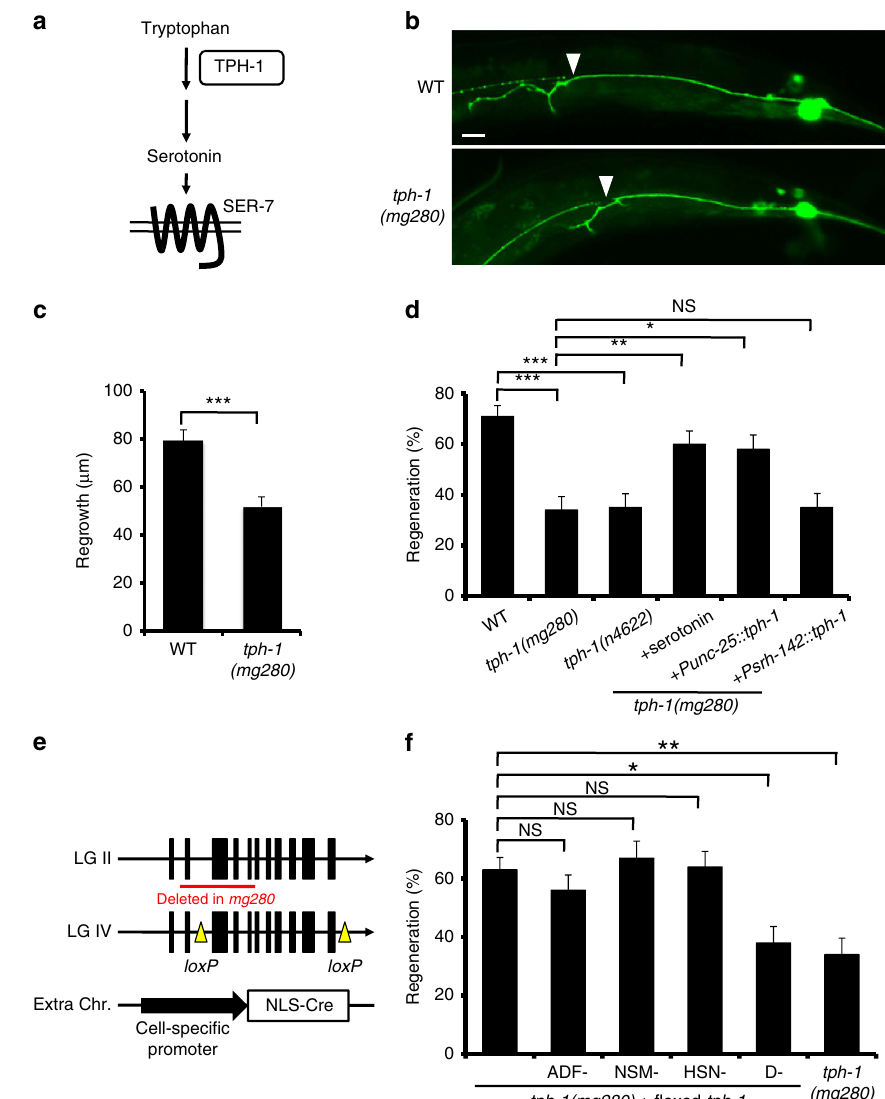
Figure 1 | Serotonin activates axon regeneration. ( a ) The synthesis of serotonin from tryptophan catalyzed by TPH-1. ( b ) Representative PLM sensory neurons in wild type and tph-1 mutant animals 24h after laser surgery. Arrowheads indicate cut sites. Scale bar ¼ 20 m m. ( c ) Regeneration of PLM sensory neurons. Lengths of PLM regrowth at 24h after laser surgery are shown. Error bars indicate s.e.m. *** P o 0.001 ( n Z 30; unpaired t -test, two-tailed and unequal variances). ( d , f ) Regeneration of D-type motor neurons. Percentages of axons that initiated regeneration 24h after laser surgery are shown. Error bars indicate 95% CI. *** P o 0.001; ** P o 0.01; * P o 0.05; NS, not significant (Fisher’s exact test, two-tailed, n Z 50). ( e ) Cell-specific deletion of tph-1 using a Cre- loxP recombination system. CI, confidence